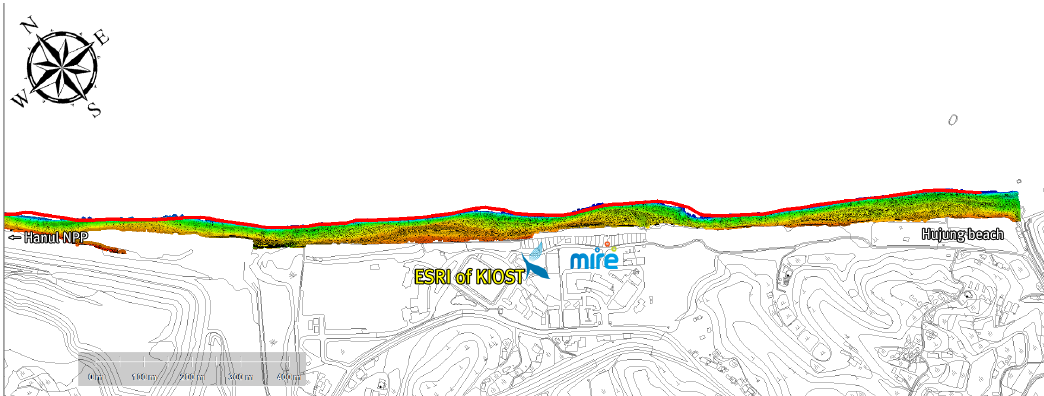
Figure 3. Comparison of shoreline positions estimated with the video monitoring system (red solid line) with land topography (green and yellow contours) measured by a ship-mounted mobile LiDAR on 12 March 2017. The seaward boundary of the colored contours determines the shoreline positions.